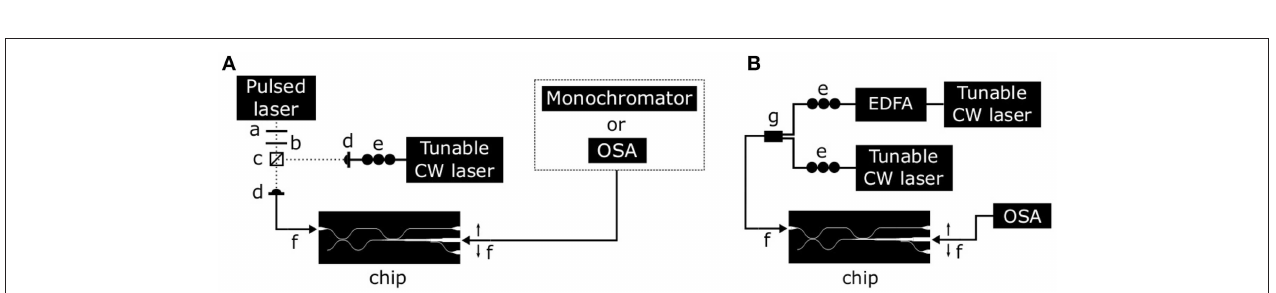
FIGURE 5 | (A) Setup for FWM experiments with a pulsed pump laser. The pump passes through a half wave plate (a), a quarter wave plate (b) and is mixed via a free space beam splitter (c) with a CW laser used as the seed. The CW laser is polarized controlled with a fiber polarization stage (e). The two lasers are then coupled via a collimator (d) into a same lensed fiber (f). This fiber inputs the pump and the seed into the chip. Another tapered lensed fiber is used to collect the output photons. The collected photons are analyzed with a monochromator or an OSA (optical spectrum analyzer). (B) Setup for FWM experiments with a CW pump. The CW pump is amplified with an EDFA. Then it is mixed via a fiber beam splitter (g) with the CW